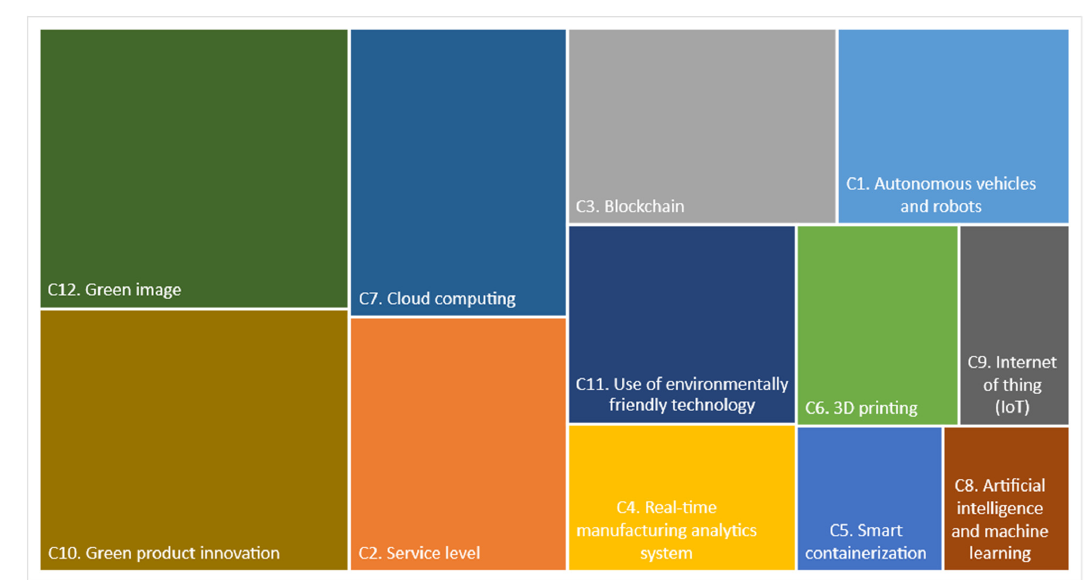
Figure 3. The impact weights of criteria from the OPA result.